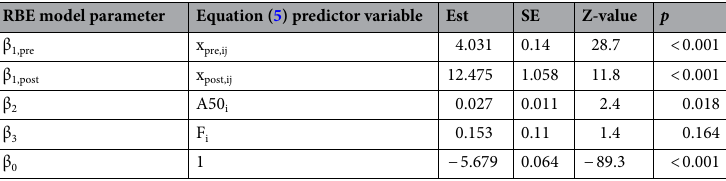
Table 5. Estimates of parameters in RBE model (Eq. 5) based on Poisson regression that includes all observed data, both pre- and post-flight with separate terms for sensitivity to gamma radiation ( β 1, pre ) and BFO dose ( β 1, post ) as well as overall age and gender effects.